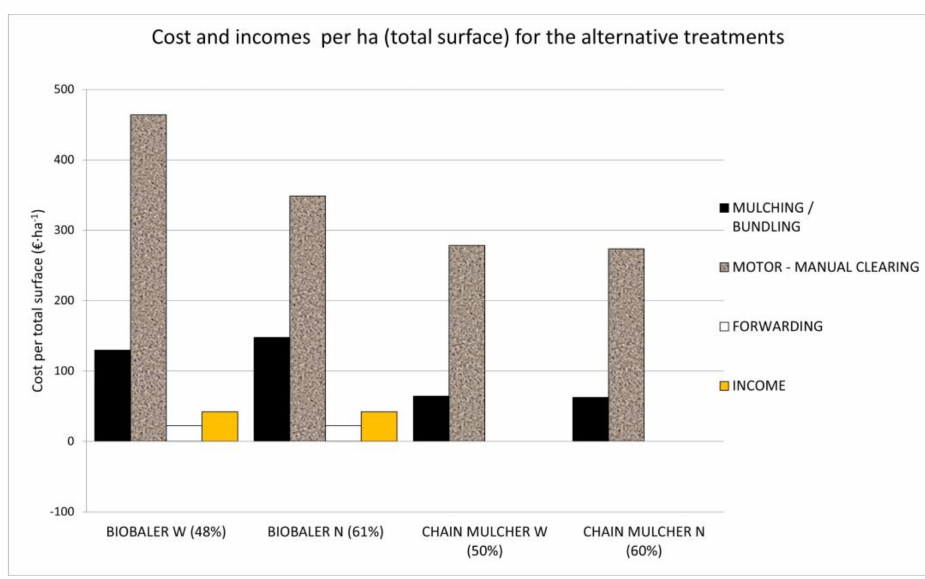
Figure 4. Economic balance for the four studied